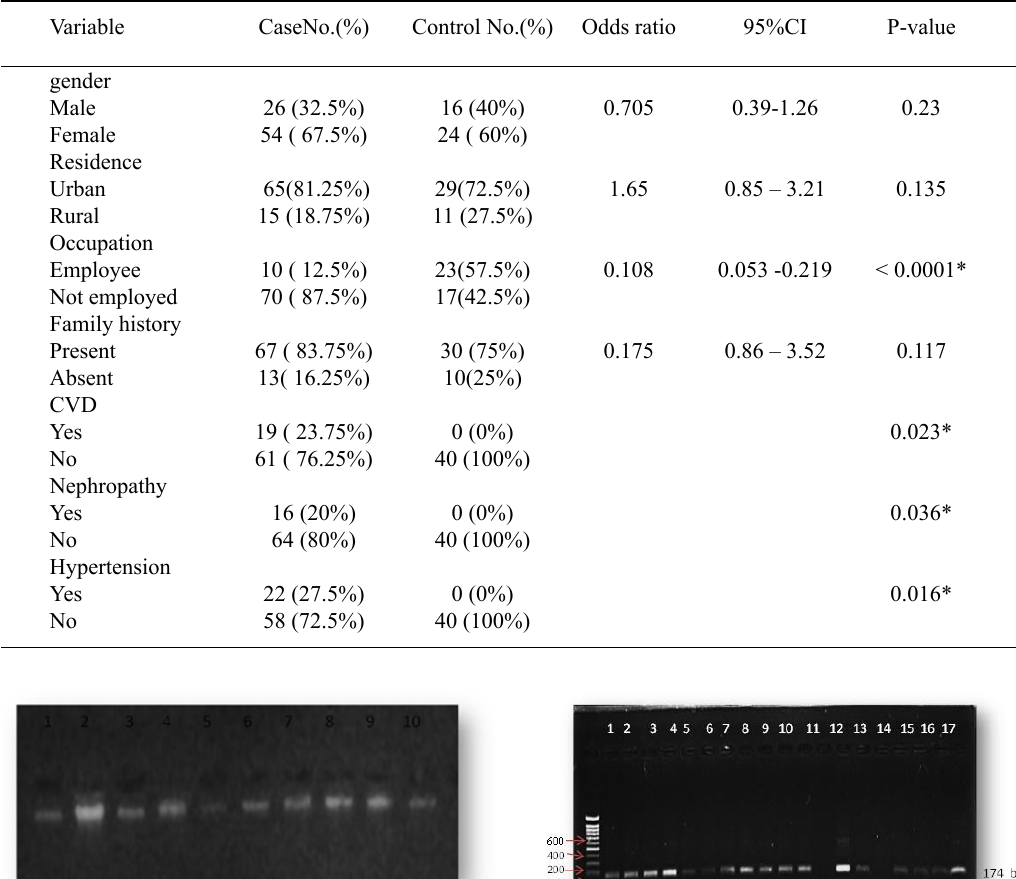
table 1. The association of study groups by study variables